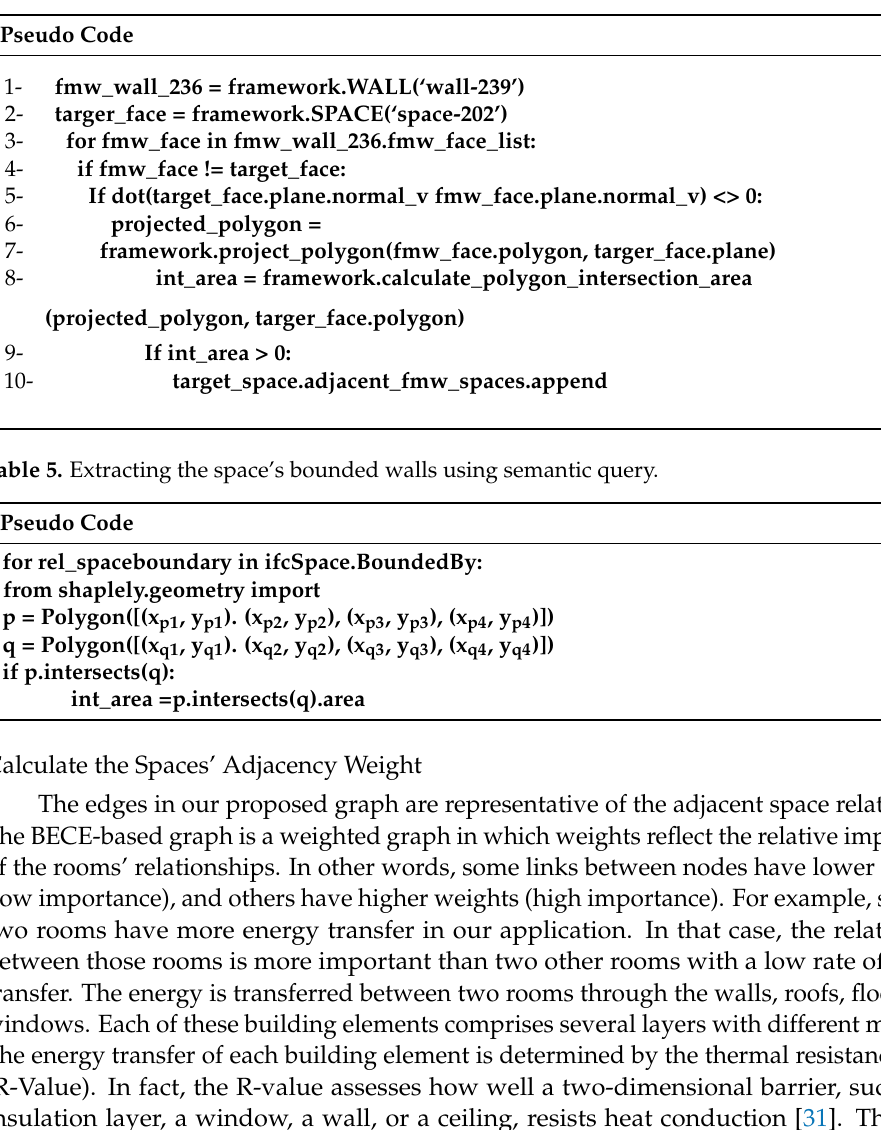
Table 4. Pseudo code for select the faces to intersect with the target face.